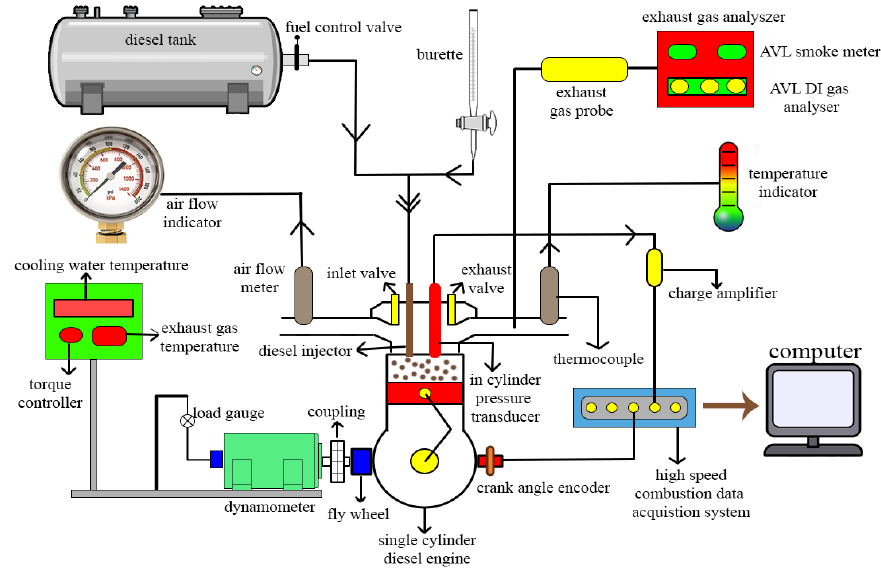
Figure 3. Schematic diagram of experimental engine setup. Table 4. Engine